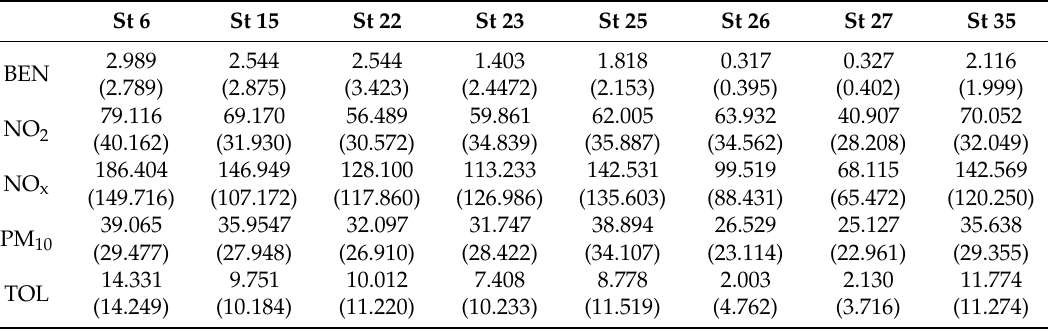
Table 2. Mean and standard deviation of pollutants in each station (BEN: benzene, NO 2 : nitrogen dioxide, NO x : nitrogen oxides, PM 10 : particles with a diameter of 10 micrometres or less and TOL: